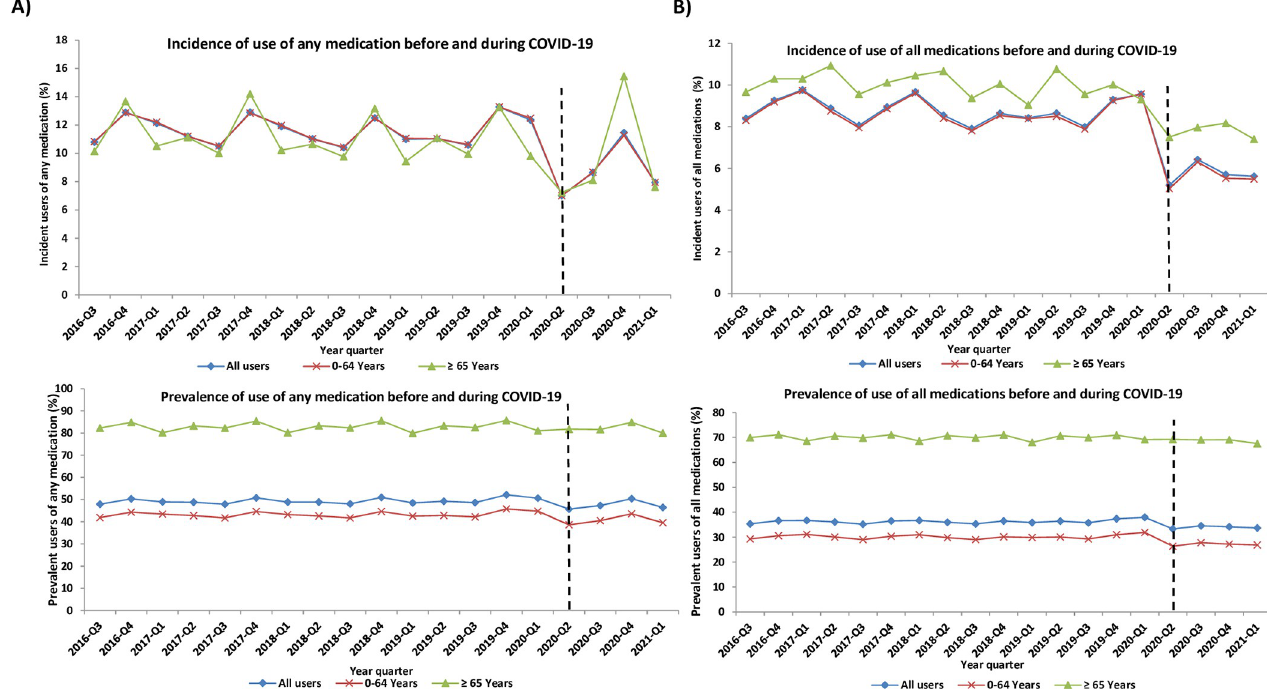
Fig 1. Incidence and Prevalence of (A) any medication and (B) all medications use stratified by age in Manitoba from Q3-2016 until Q1-2021.